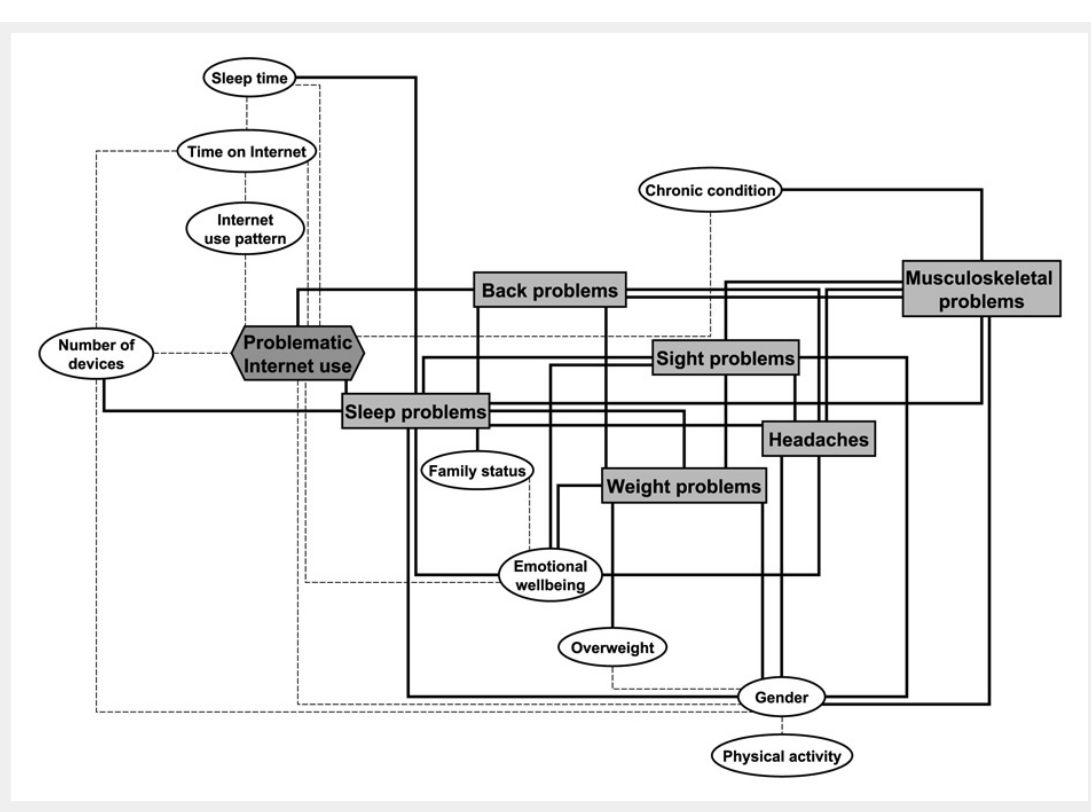
Figure 1 Log-linear model representing the associations between significant